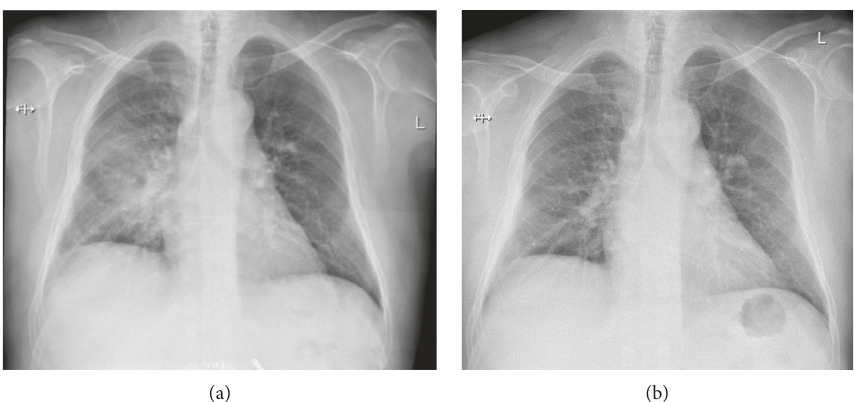
Figure 1: Chest X-ray showing right lower zone non-homogenous opacity with air bronchogram (a). Then, there was remarkable im- provement 6 months later